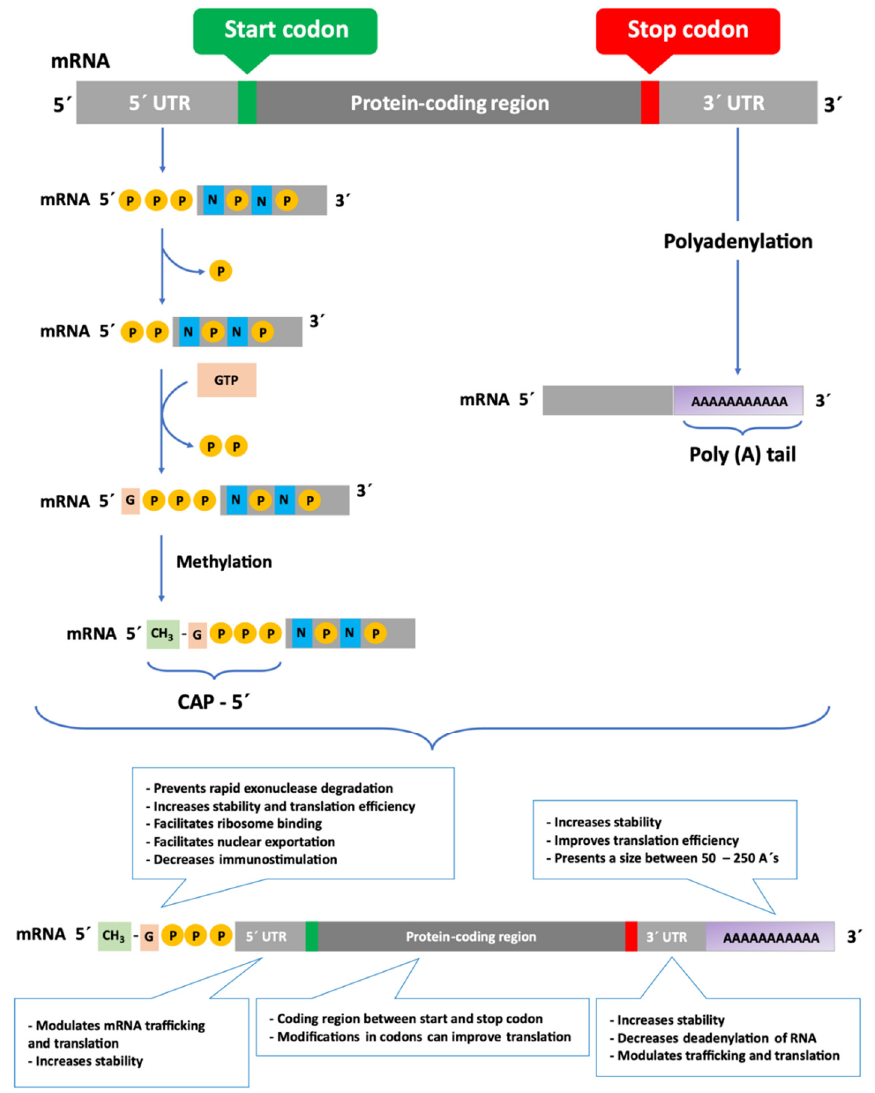
Figure 1. Schematic representation of eukaryotic mRNA, integrating the fundamental regions for its processing, such as 5 ′ UTR, protein coding region, and 3 ′ UTR. Schematization of polyadenylation process and introduction of Cap at the 5 ′ end, as well as its biological and structural functions. P—Phosphate group; N-Nucleotide; CH3—Methyl group; A—Adenine; G-Guanine; UTR—Untranslated region.